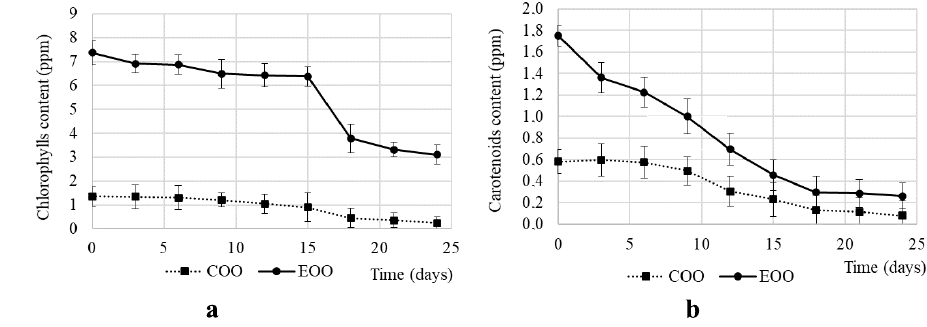
Fig. 4: Chlorophylls (a) and carotenoids (b) contents of the COO and EOO under accelerated storage.